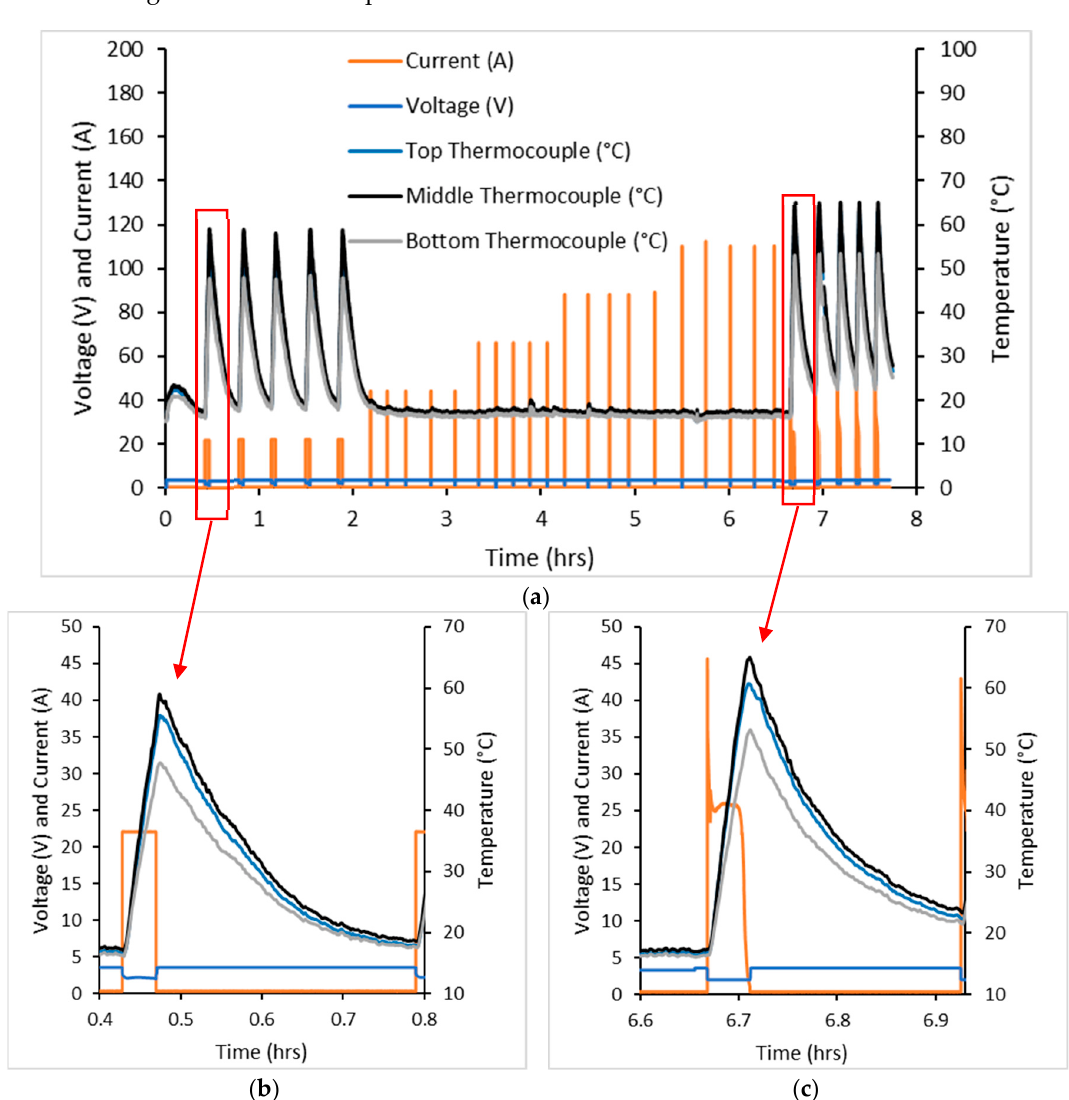
Figure 1. Typical cell failure test profile. ( a ) shows the entire plot, ( b ) a closer view of 20 C constant current (CC) discharge, ( c ) a closer view of constant voltage (CV) discharge.